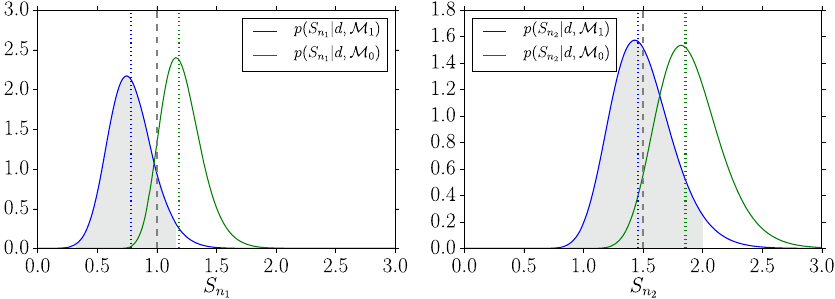
Fig. 19 Marginalized posterior distributions for the detector noise variances S n panel ) for the signal-plus-noise model M 1 ( blue curves ) and the noise-only model M 0 ( green curves ), respectively. The actual values of S n lines .The95%Bayesiancredibleintervalsforthesignal-plus-noisemodel M 1 arethe grey-shadedregions . For comparison, the frequentist estimators of S n green ) dotted vertical